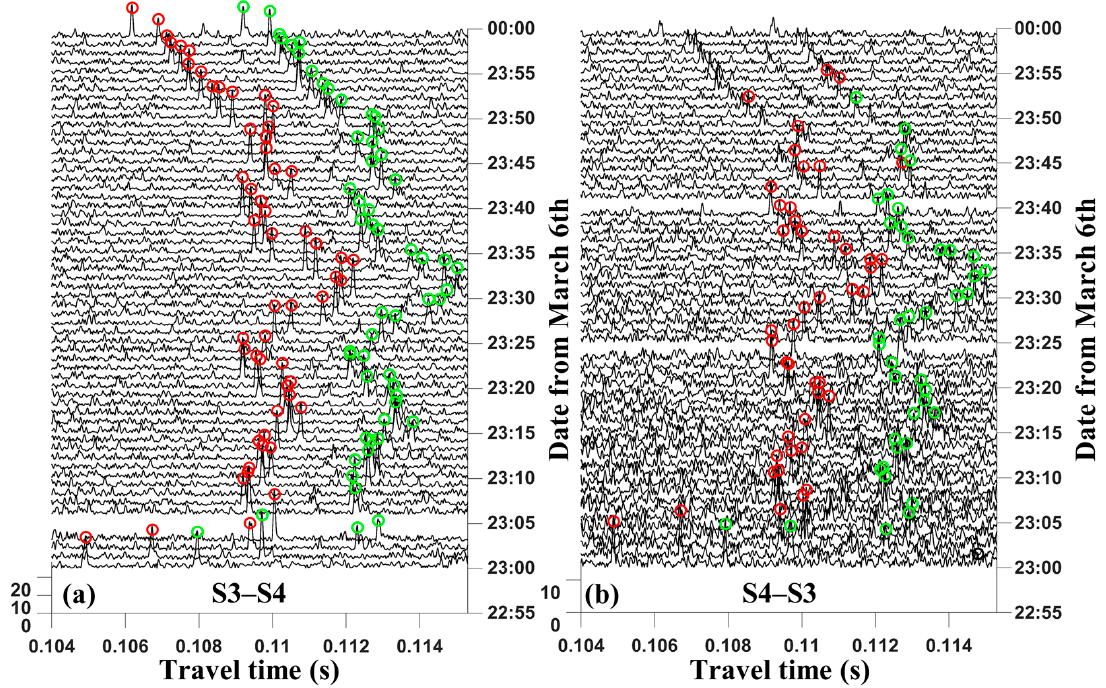
Figure 5. Multi-peak identification of S3 to S4. ( a , b ) are the results of peak extraction from S3 to S4 and S4 to S3 after correlation. The meanings of coordinate axis and circles are same as in Figure 3.